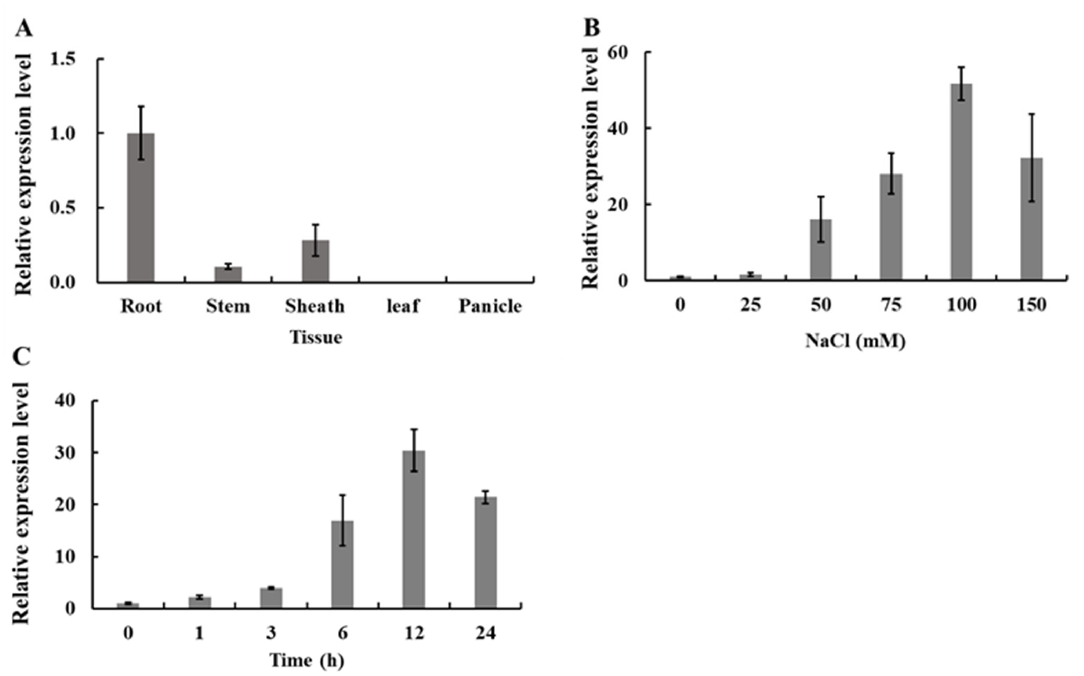
Figure 1. Expression profile of OsWRKY54 . ( A ) The expression level of OsWRKY54 in the roots, stems, leave, leaf sheaths, and panicles of rice plants at the heading stage. ( B ) The dose-dependent expression level of OsWRKY54 in roots in response to NaCl treatment. Five-day-old rice seedlings were subjected to NaCl with different concentrations (0, 25, 50, 75, 100, and 150 mM) for 12 h. ( C ) The time-course expression level of OsWRKY54 in rice roots in response to NaCl treatment. Five- day-old rice seedlings were treated with 100 mM NaCl at different times (0, 1, 3, 6, 12, and 24 h). Histone H3 was used as an internal reference. Data represent mean ± SD (n = 4).